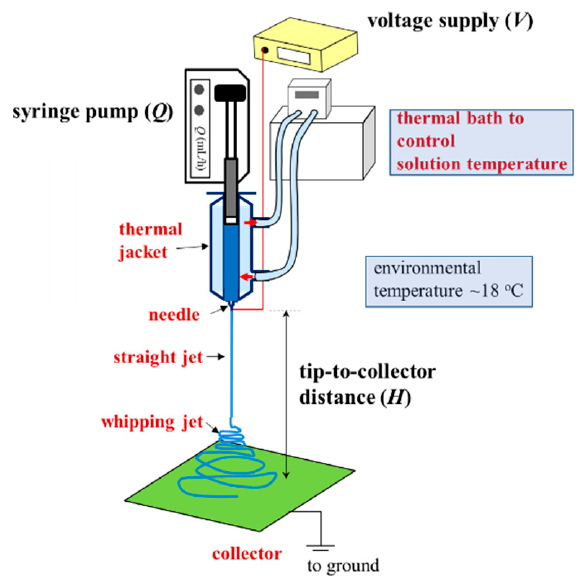
Figure 12. Low-temperature electrospinning process designed to ensure the continuous electrospin- ning of a one-phase a-PNIPAM aqueous solution. A thermal jacket was used to enclose the polymer solution to maintain a desired temperature ( T solution ), controlled by a thermal bath with circulating water. The processing parameters are Q , V and H . The environmental temperature was fixed at 18 °C.